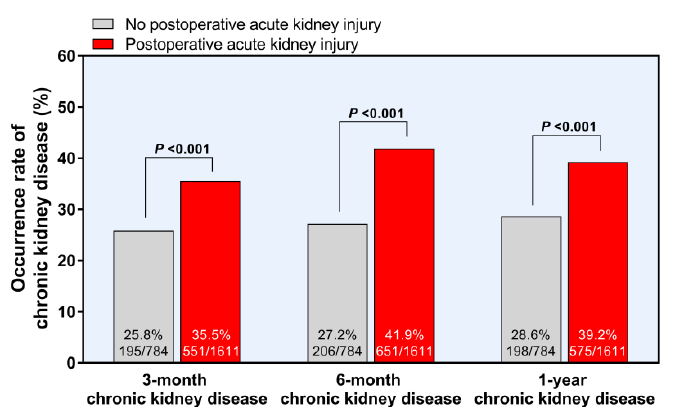
Figure 3. Development of chronic kidney disease after postoperative acute kidney injury.